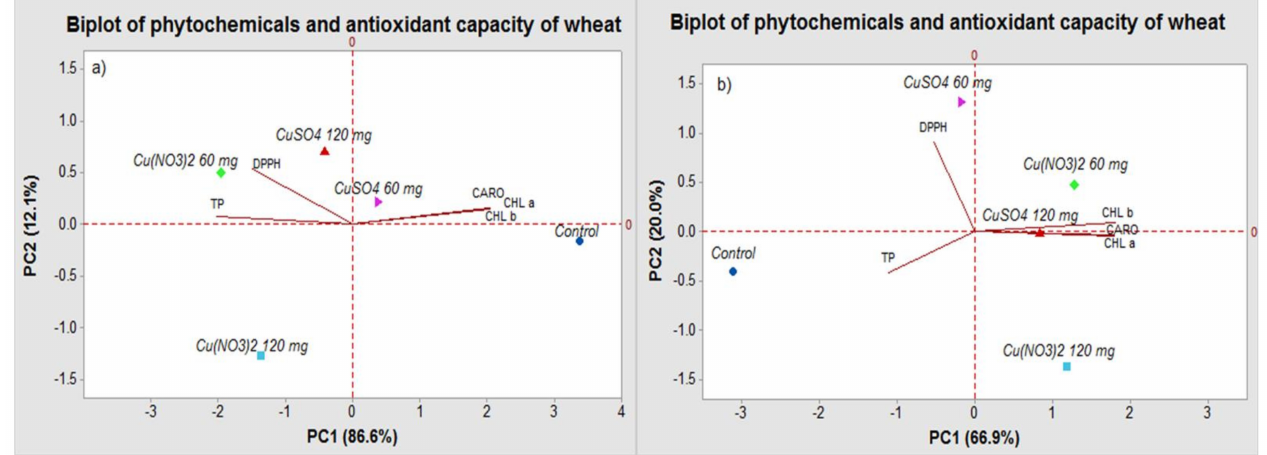
Figure 4. Correlation between the conditions of plant growth, phytochemicals and antioxidant activity of wheat. TP: total polyphenols; CHL a (chlorophyll a); CHL b (chlorophyll b); CARO (total carotenoids); ( a ) series I; ( b ) series